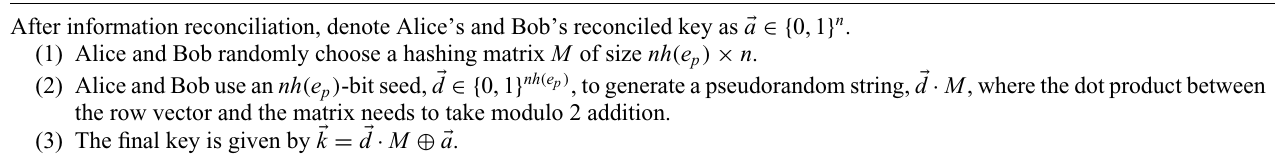
TABLE III. Stream privacy